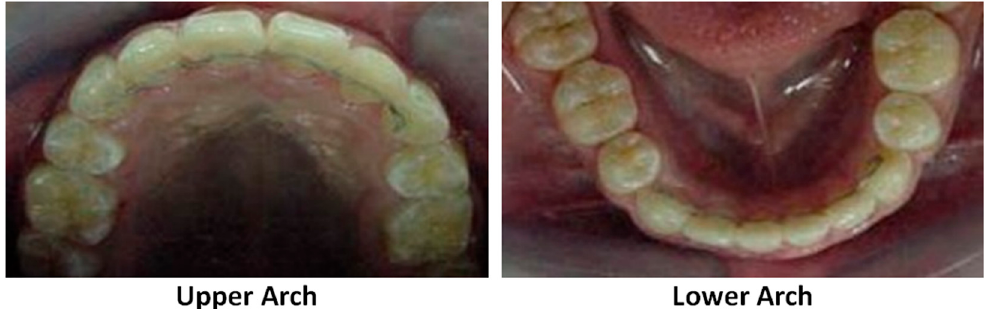
Figure 2. Illustration of the Lingual Fixed Retainer of the upper arch ( left ) and lower arch ( right ).